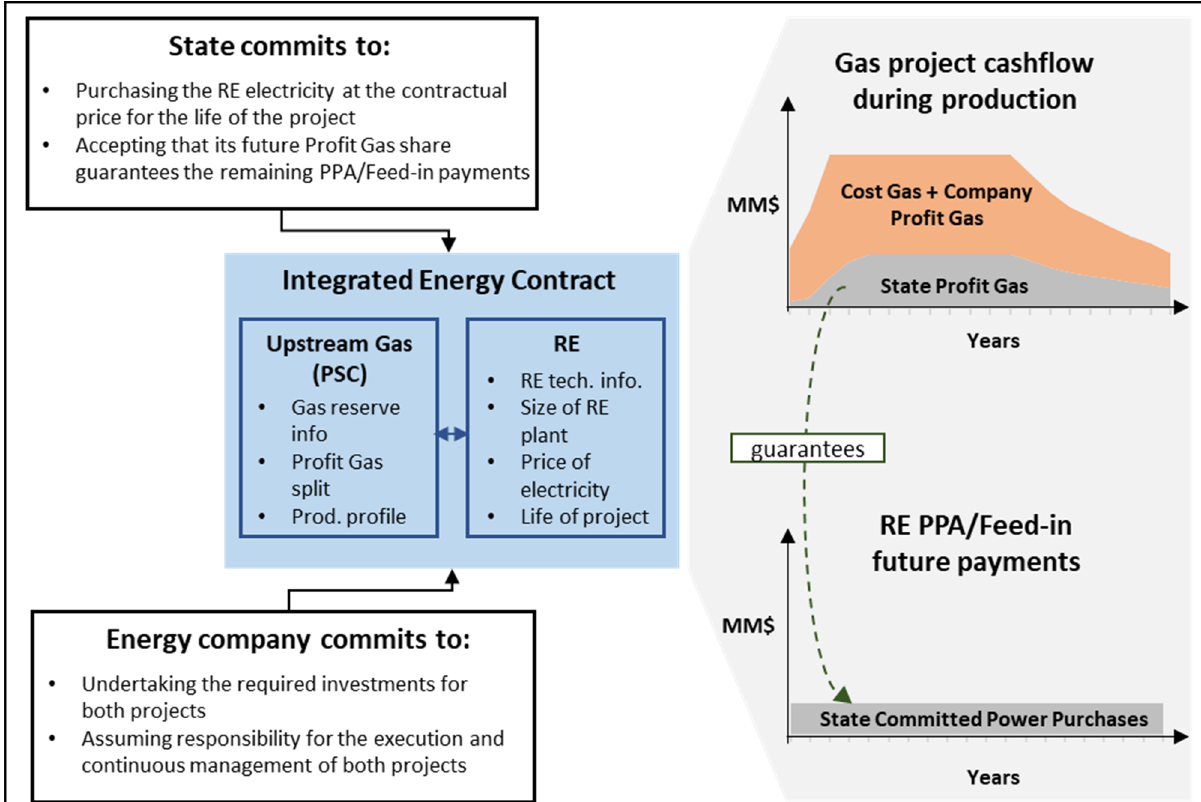
Figure 1. Structure of the proposed integrated energy contract.